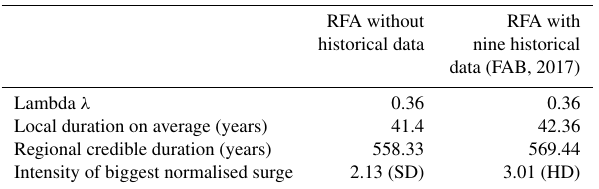
Table 2. Summary table of the results obtained with the application of FAB method for Region